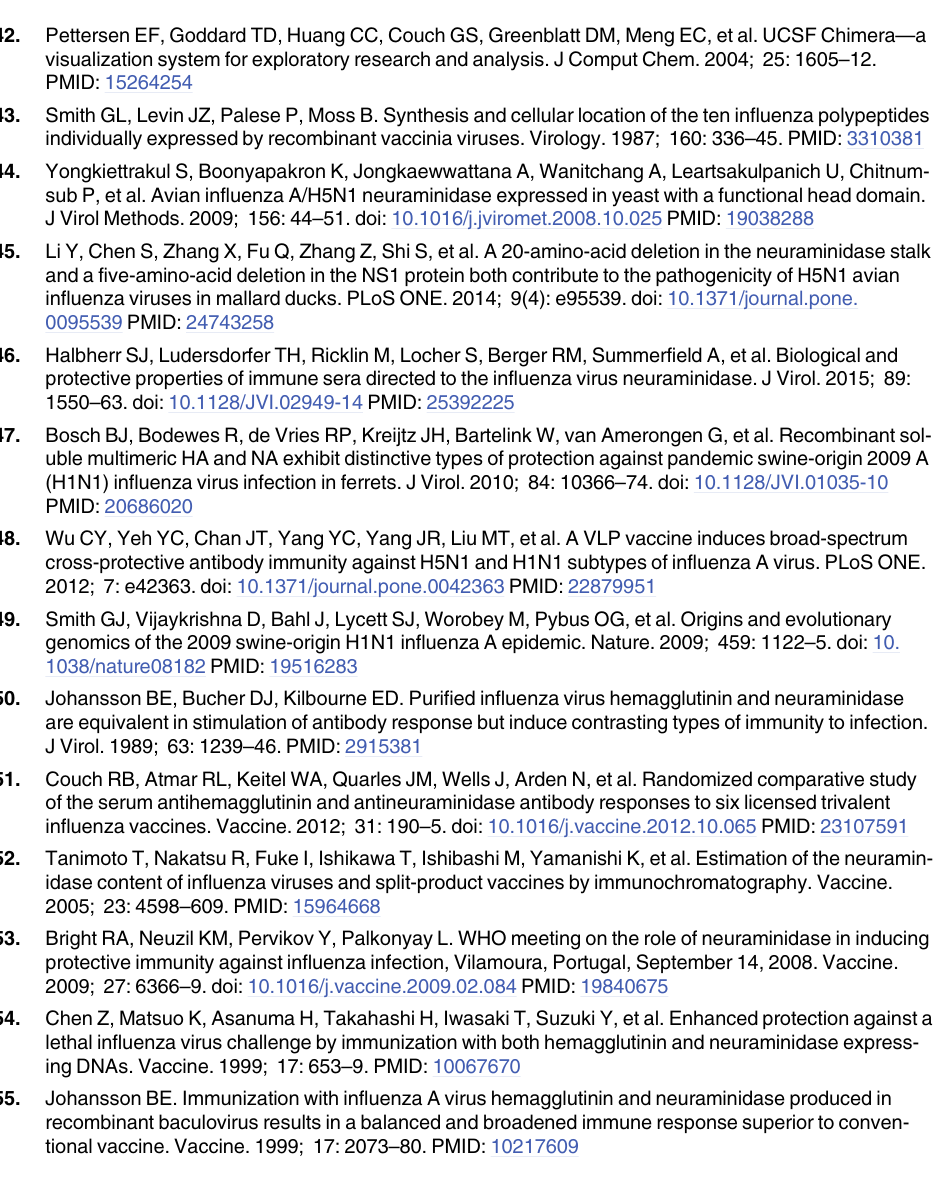
PLOS ONE | DOI:10.1371/journal.pone.0153183 April 7,